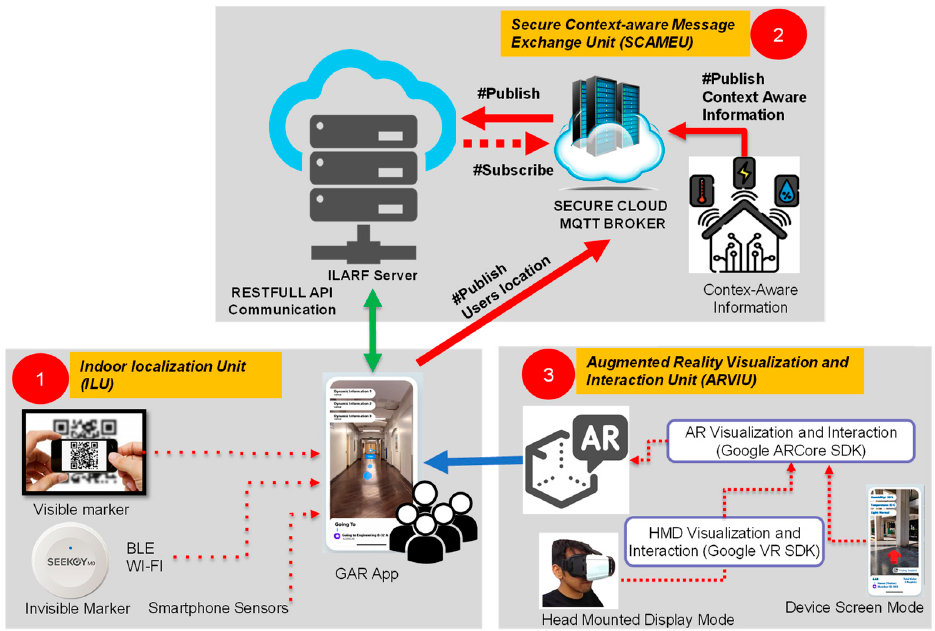
Figure 9. GAR implementation